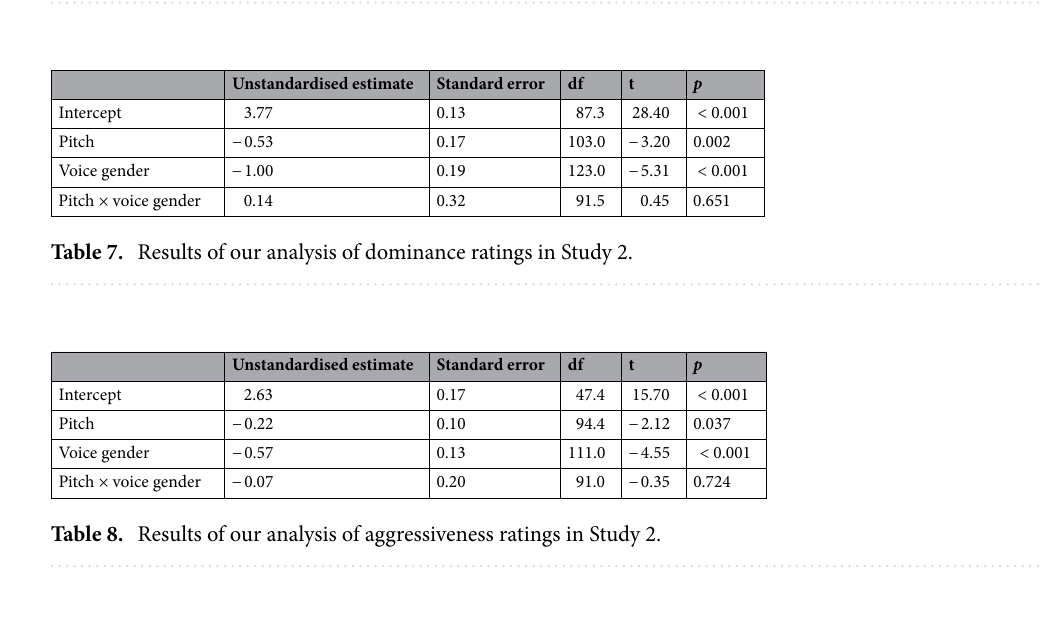
Table 6. Results of our analysis of trustworthiness ratings in Study 2.